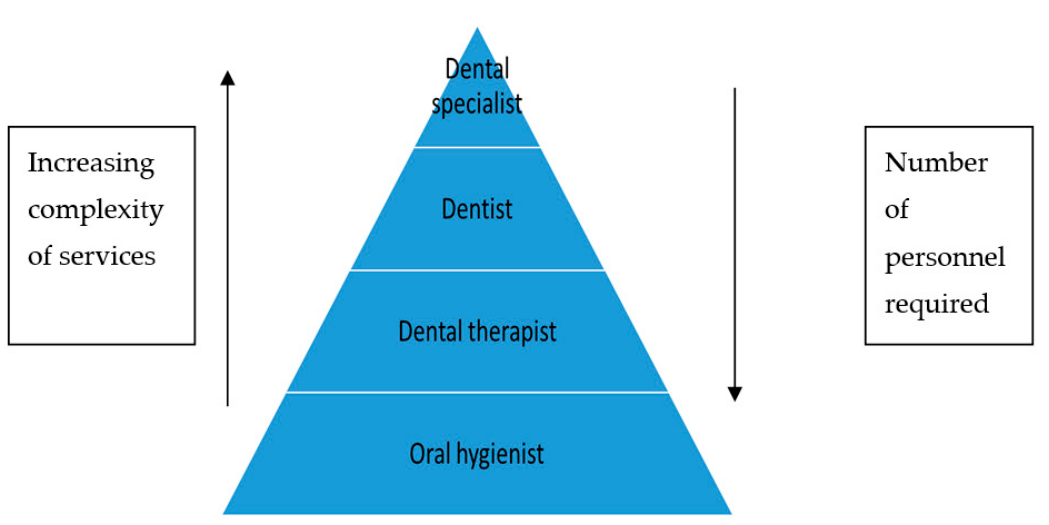
Figure 1. Breakdown of oral personnel in terms of delivery of services.